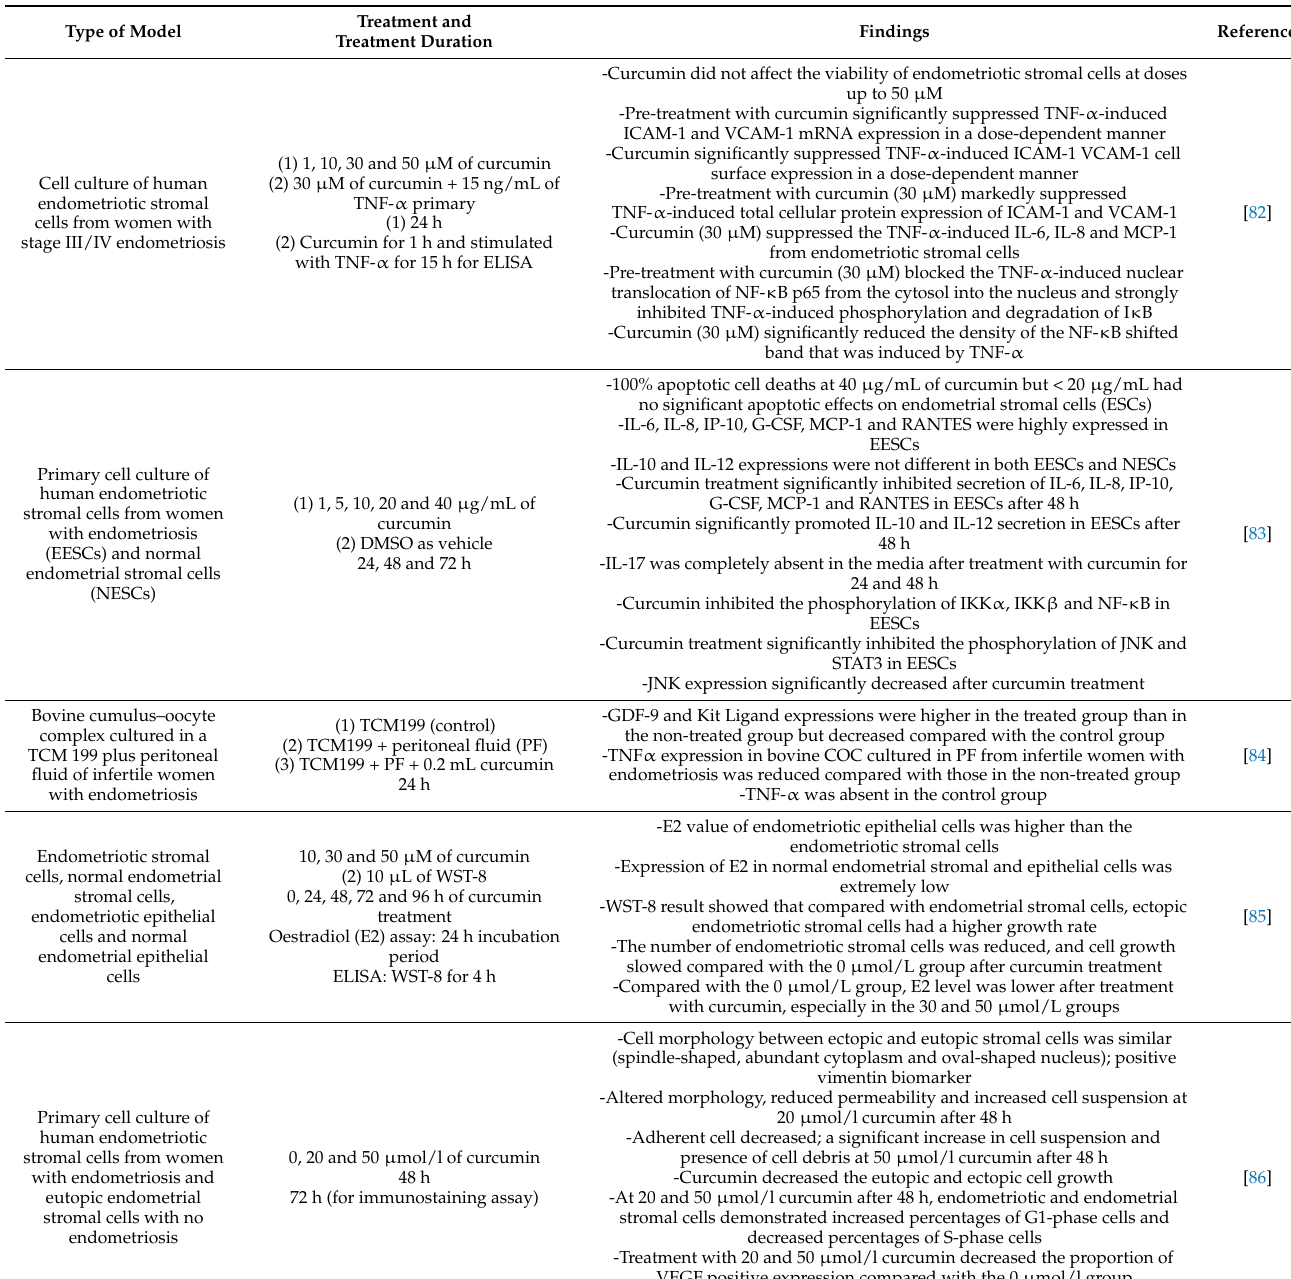
Table 5. Summary of the effects of curcumin on endometriosis in in vitro